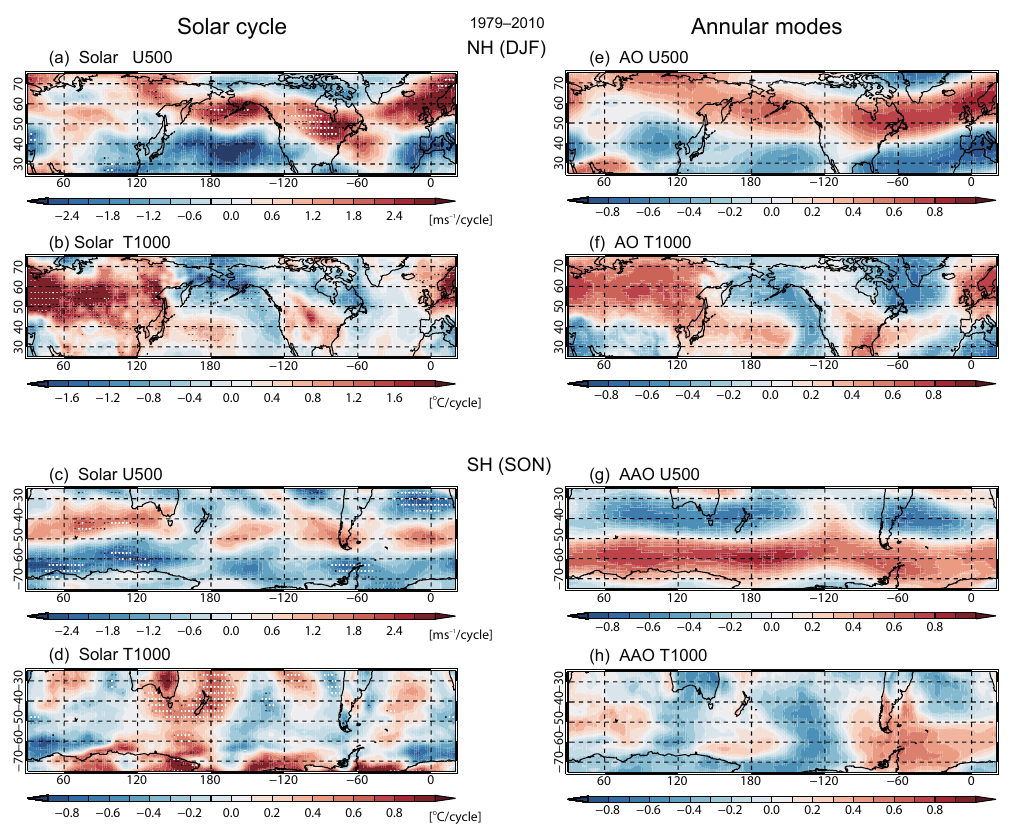
Figure 3. Solar regression coefficient extracted by the MLR technique for the DJF mean NH (a) 500hPa zonal mean wind, and (b) surface temperature. Panels ( c and d ): same as ( a and b ), but for the SON mean in the SH. Panels ( e and f ): same as ( a and b ), except for the correlation with surface NAM index. Panels ( g and h ): same as ( c and d ), except for the surface SAM index. The period of analysis is 1979–2010. Stippled regions with black and white dots indicate statistical significance at the 90 and 95% level,